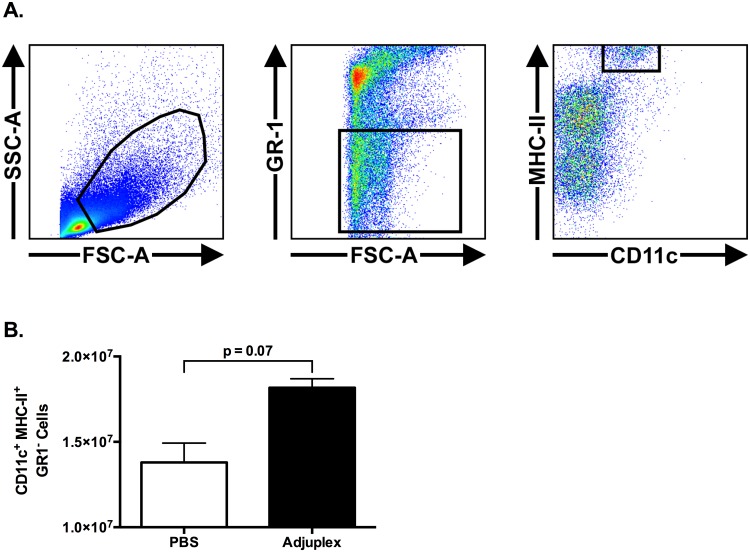
Effect of Adjuplex on Conventional Dendritic Cells in the Vaccine Draining Lymph Node After Subcutaneous Vaccination.Mice were vaccinated by SQ injection with 10 μg OVA in 50 μl of PBS with and without either 5% ADJ. The vaccine draining lymph nodes were collected at 48 hours after vaccination and analyzed by flow cytometry. (A) Gating strategy for CD11c+/GR1-/MHC-IIHI cells among all cells with forward scatter greater than, and side scatter equal to or greater than lymphocytes. (B) Number of CD11c+/GR1-/MHC-IIHI cells in DLNs. Data shown are representative of two independent experiments.